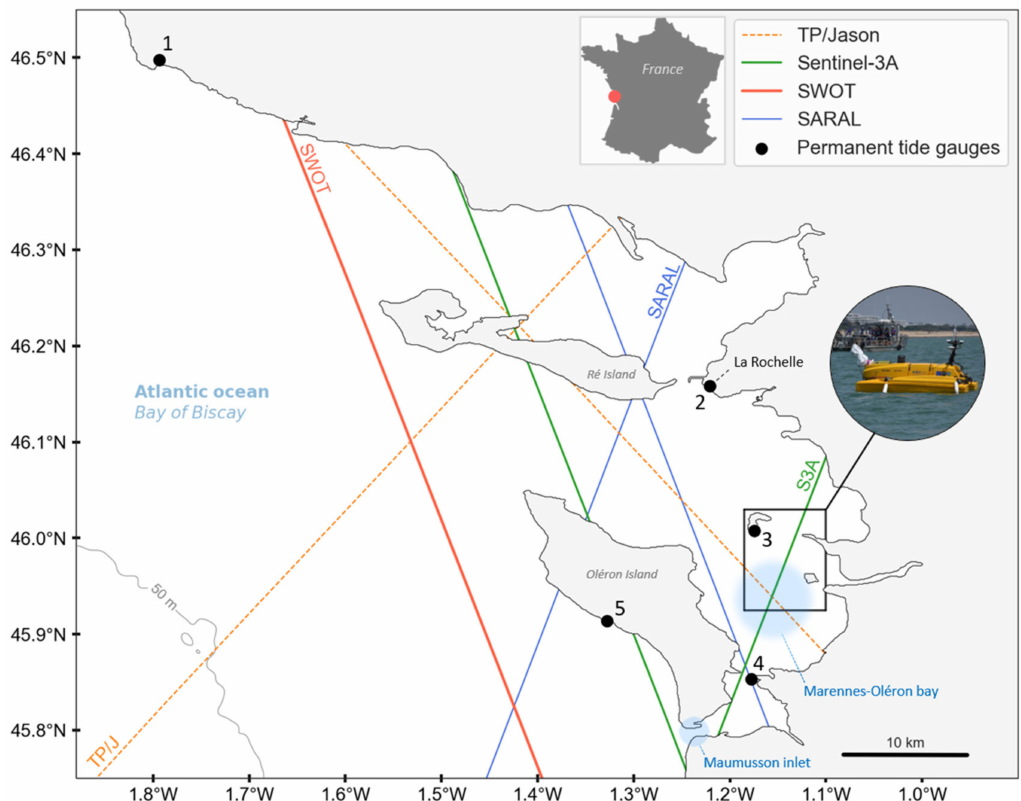
Figure 1. Overview of the main nominal altimetry tracks and permanent tide gauges in the Pertuis-Charentais area. Permanent tide gauges are represented by black dots: 1—Les Sables d’Olonne (LSDO), 2—La Rochelle La Pallice (LROC), 3—Aix Island (AIX), 4—Bourcefranc-le-Chapus (BOURC) and 5—La C ô tini è re (COT). Nominal tracks of actual and future altimetric missions are represented by orange (TP/Jason), blue (SARAL/AltiKa), green (Sentinel-3A) and red (SWOT— nadir) lines. The black rectangle is the area where the PAMELi USV survey took place. Two blue areas represent the Maumusson inlet and the Marennes-Ol é ron